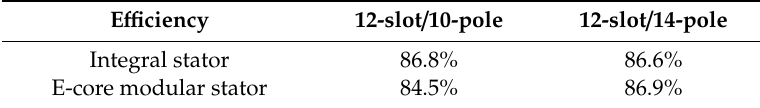
Table 3. E ffi ciency comparison of modular and integral